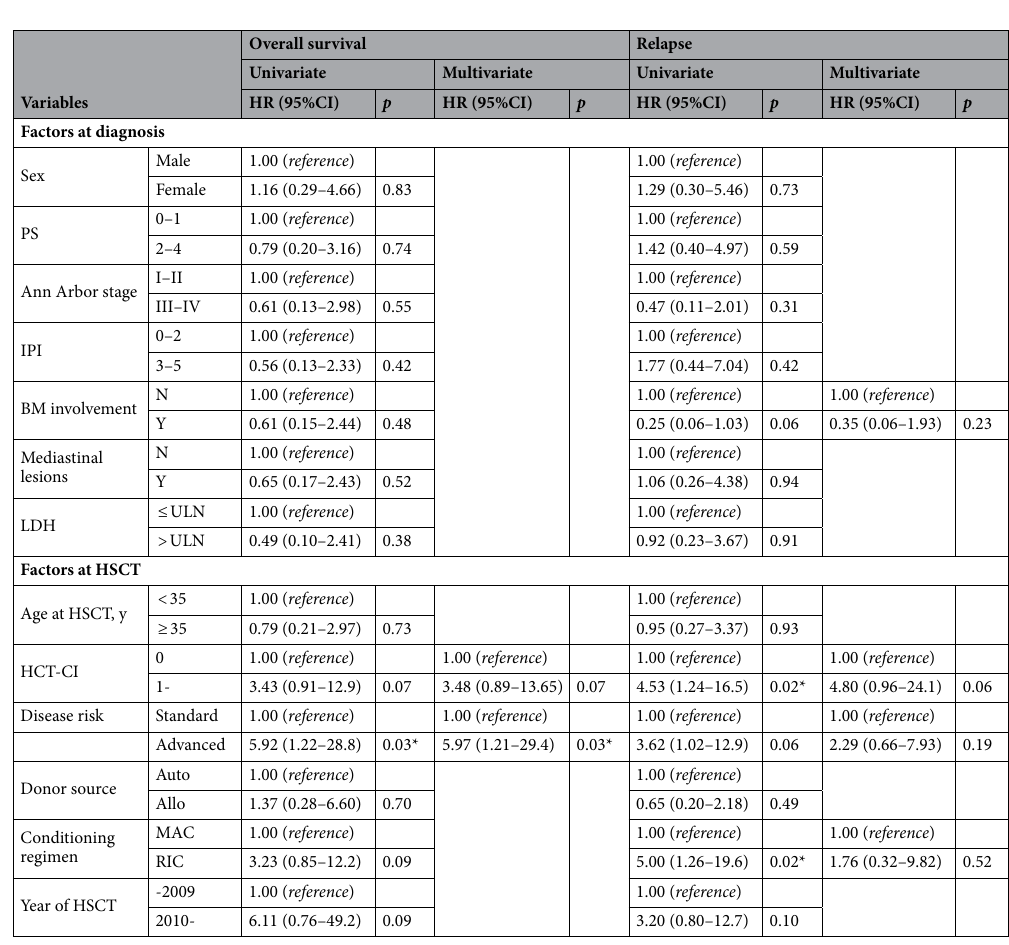
Table 3. Univariate and multivariate analyses of prognostic factors. HR hazard ratio, CI confidence interval. Other abbreviations are shown in Tables 1 and 2.